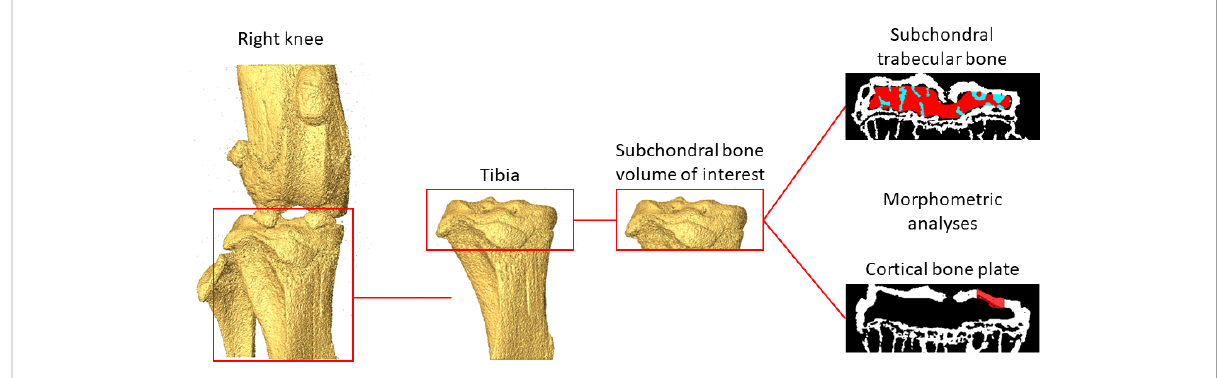
FIGURE 1 Example of the analysed regions of interest in the subchondral trabecular bone and cortical bone